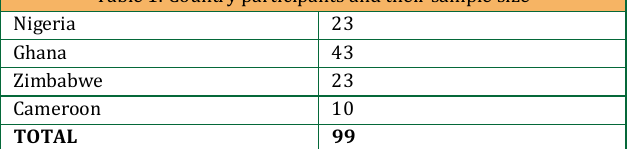
Table 1: Country participants and their sample size Nigeria